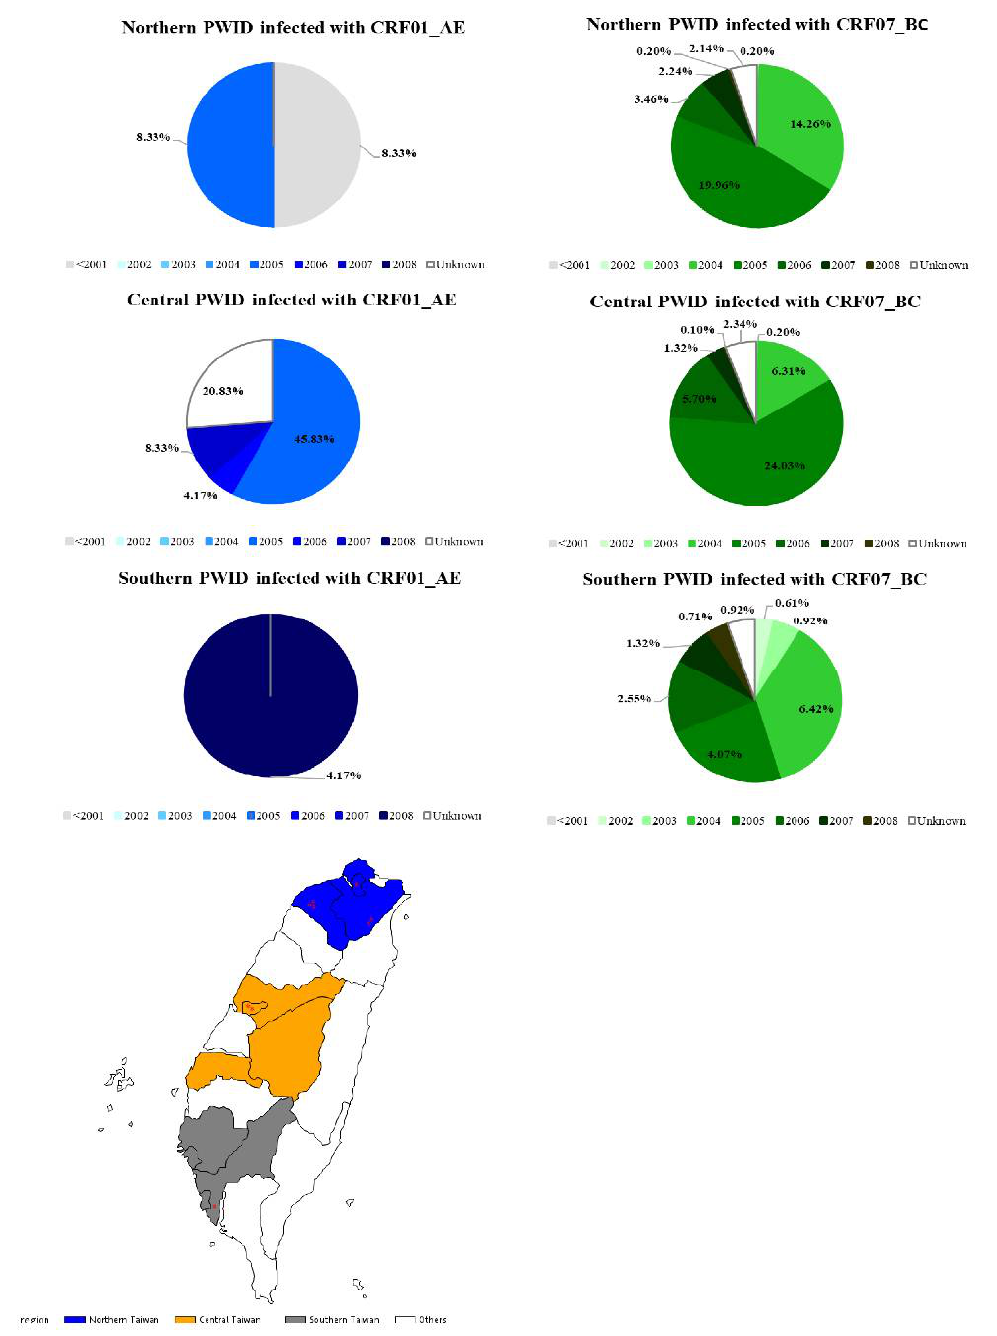
Figure A3. Distribution of Taiwanese PWID infected with HIV-1 CRF01_AE ( n = 24), HIV-1 CRF07_BC ( n = 982), and HCV subtype 6w ( n = 9) during 2004–2008. Each strain was labeled with a different color to denote patient characteristics, including collection place and year of HIV-1 diagnosis. The proportion of viral strains circulated into Northern-Central-Southern Taiwan per year, divided by total cases infected with the same strain, is shown in pie charts. Because Taiwanese PWID infected with HCV-6w were rare, we directly labeled their locations on the map. Table A1. Distribution of HCV genotypes/subtypes in the different groups among Taiwanese PWID.